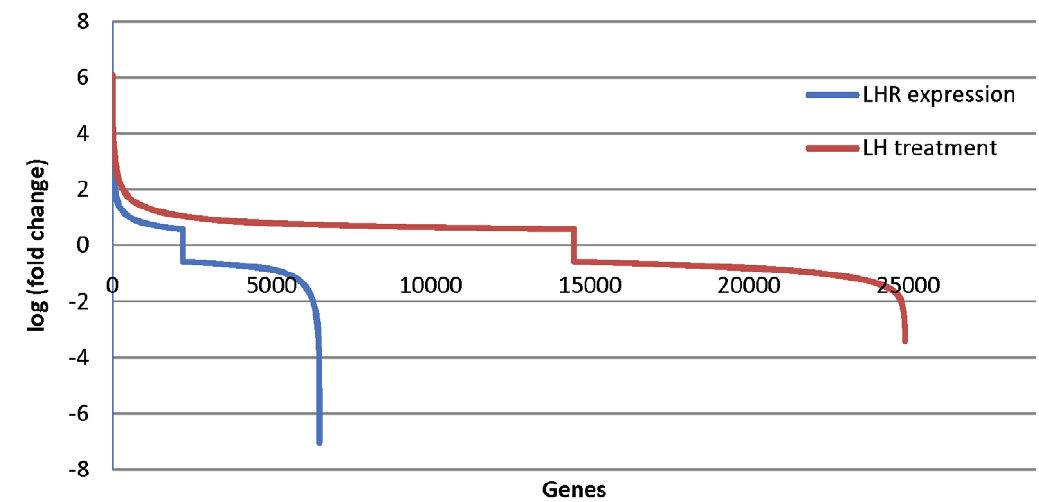
Figure 2. Distribution of the expression change of mRNAs in this study as cells express LHR and are activated by LH. doi:10.1371/journal.pone.0021730.g002 (Figure 5). The prevalence of high correlations may indicate that the microRNA is intronic or upstream to the correlated gene since they may share the same regulatory element and be transcribed